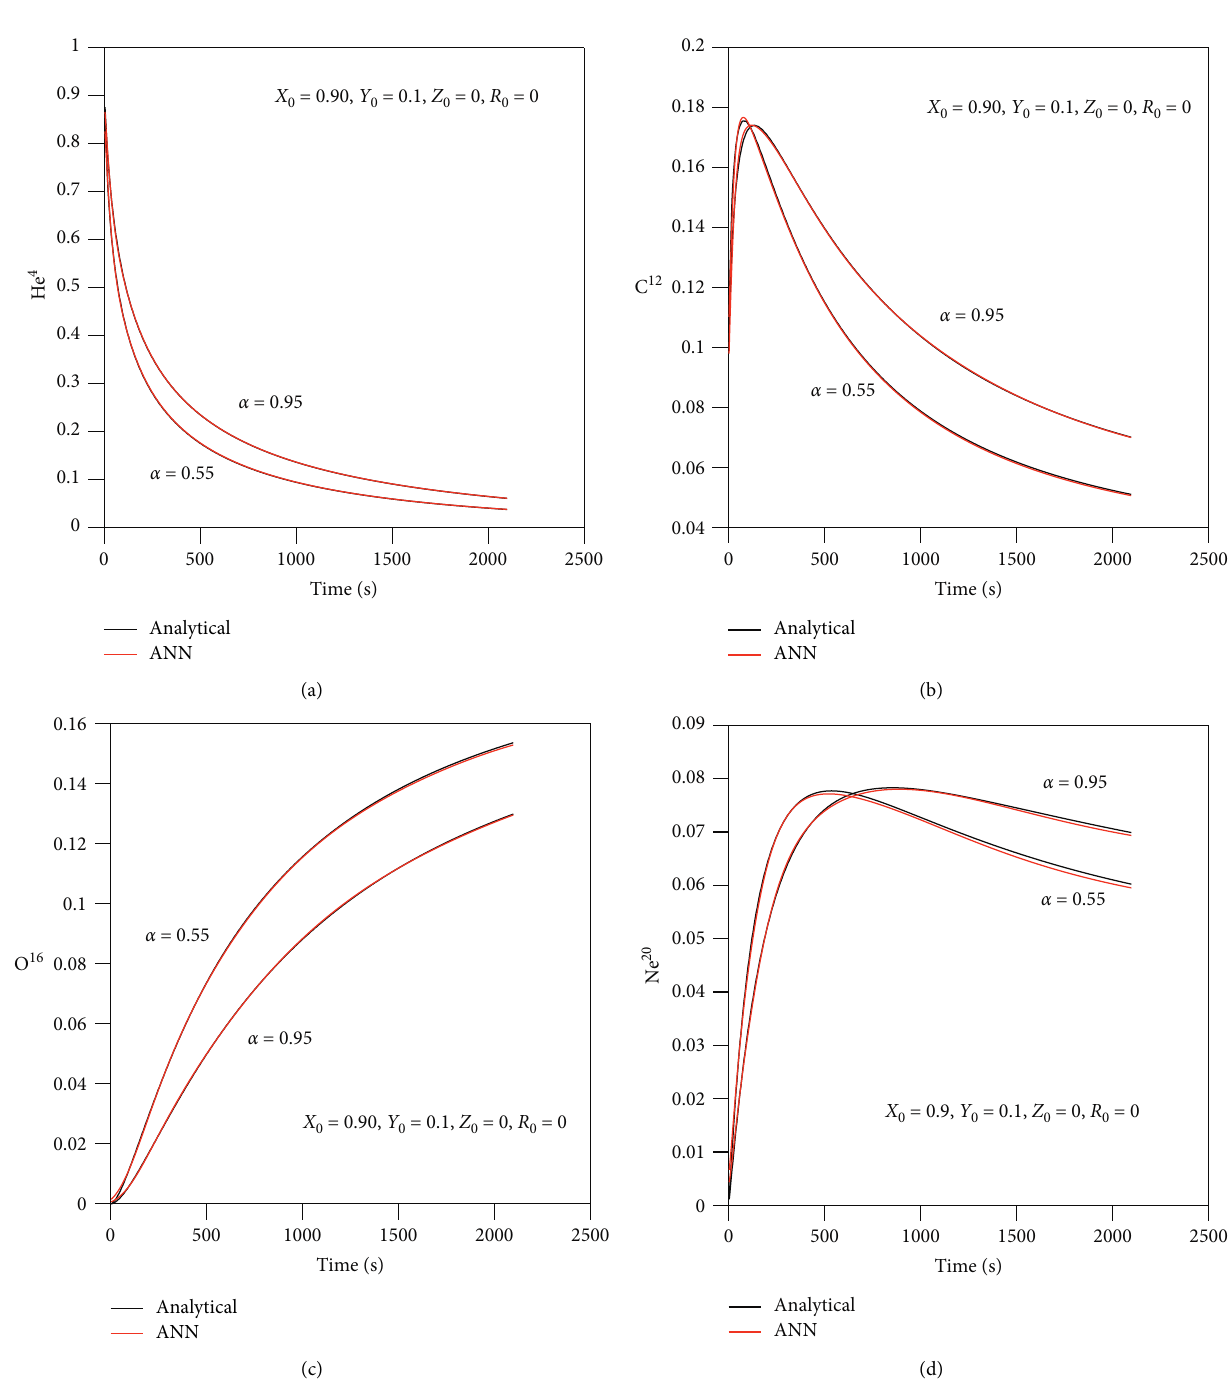
Figure 7: The distribution of the product abundance with time for the rich helium burning network, X